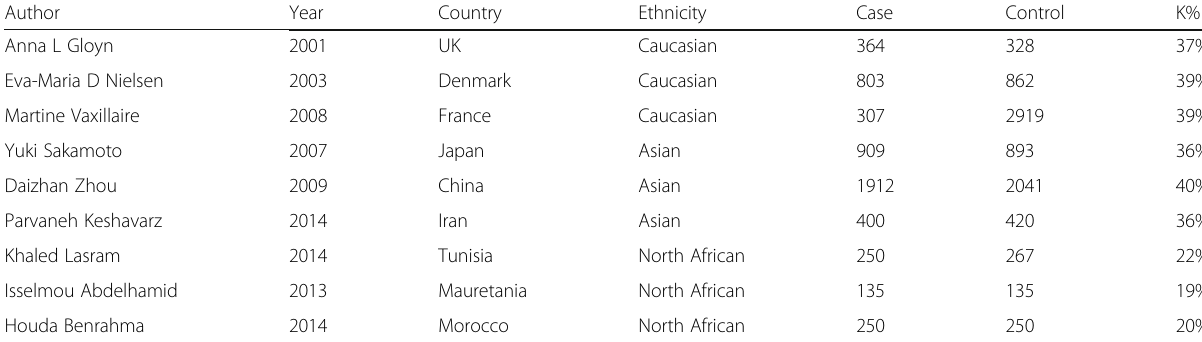
Table 3 The prevalence of the K allele among different